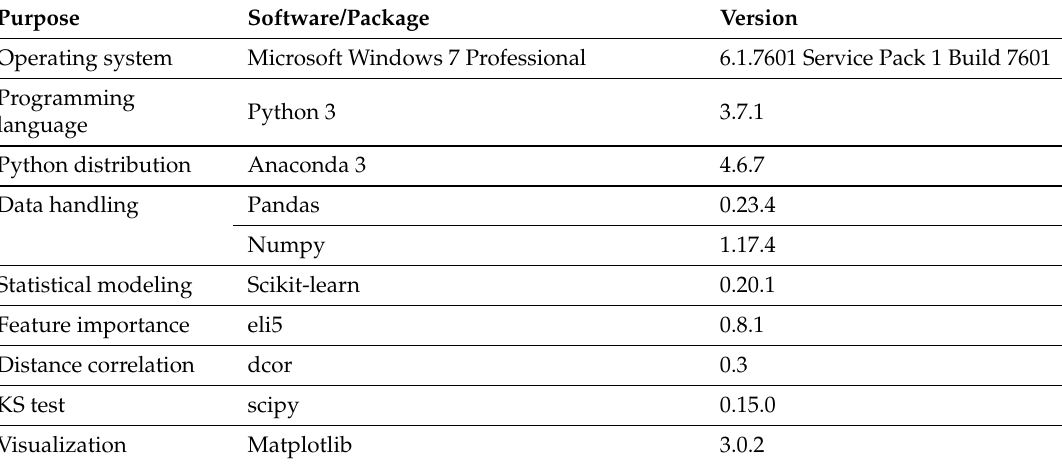
Table A2. Software specifications for the